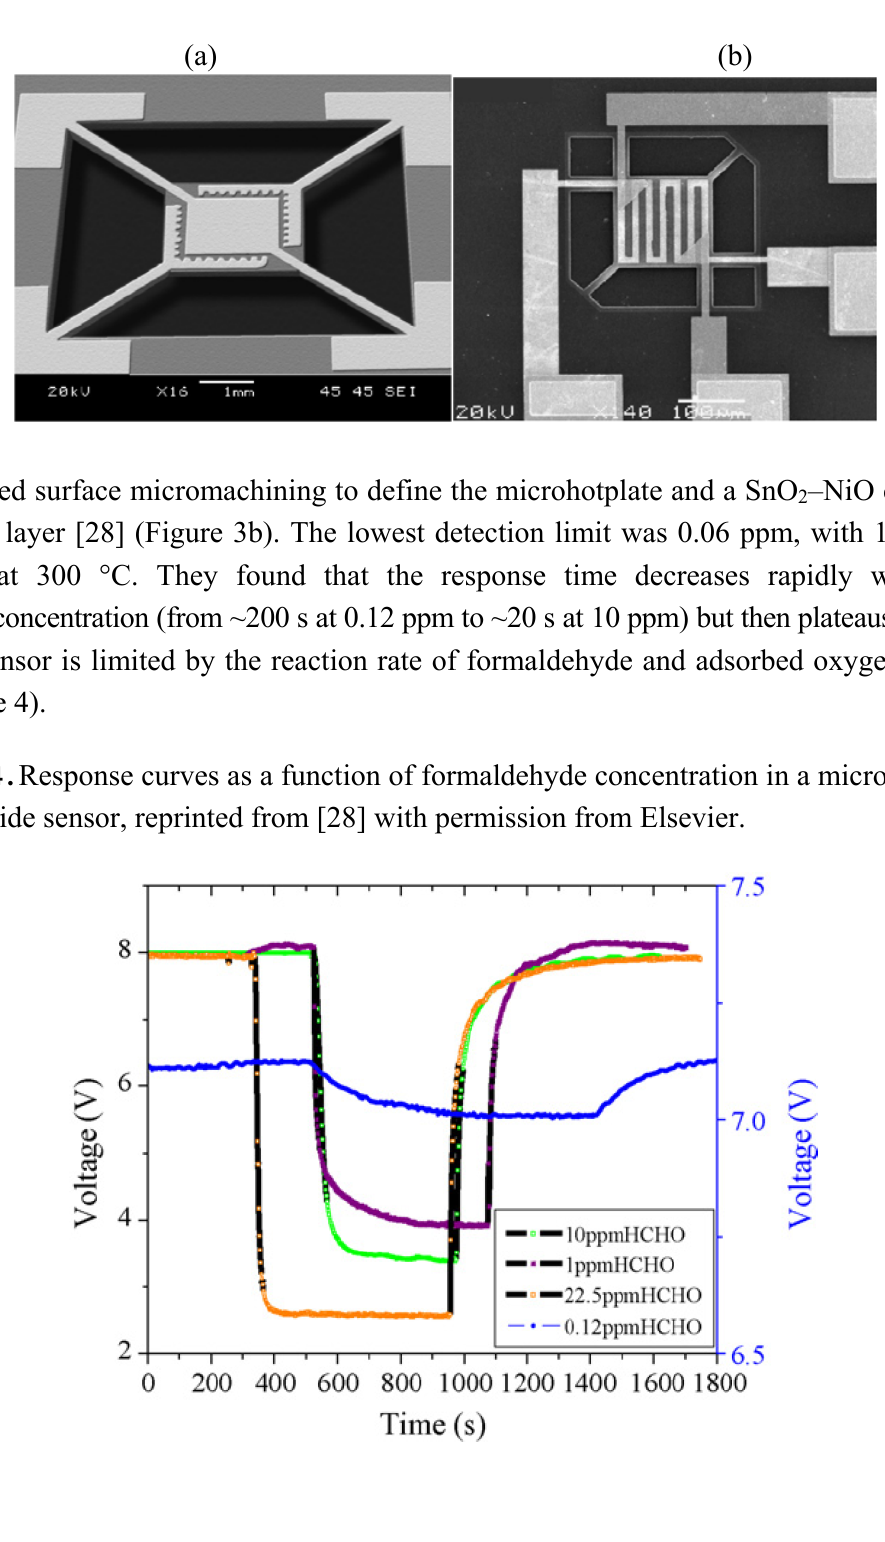
Figure 3. Formaldehyde sensor with integrated Pt micro-heater on a suspended silicon nitride structure, reprinted from [43] with the permission from Elsevier and on a suspended SiO /SiN /SiO membrane, reprinted from [28] with permission from Elsevier. 2 x 2